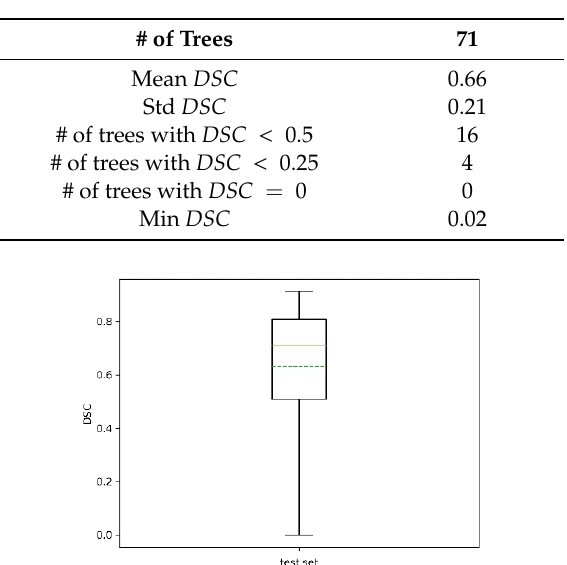
Table 5. Statistics of DSC for the test set.